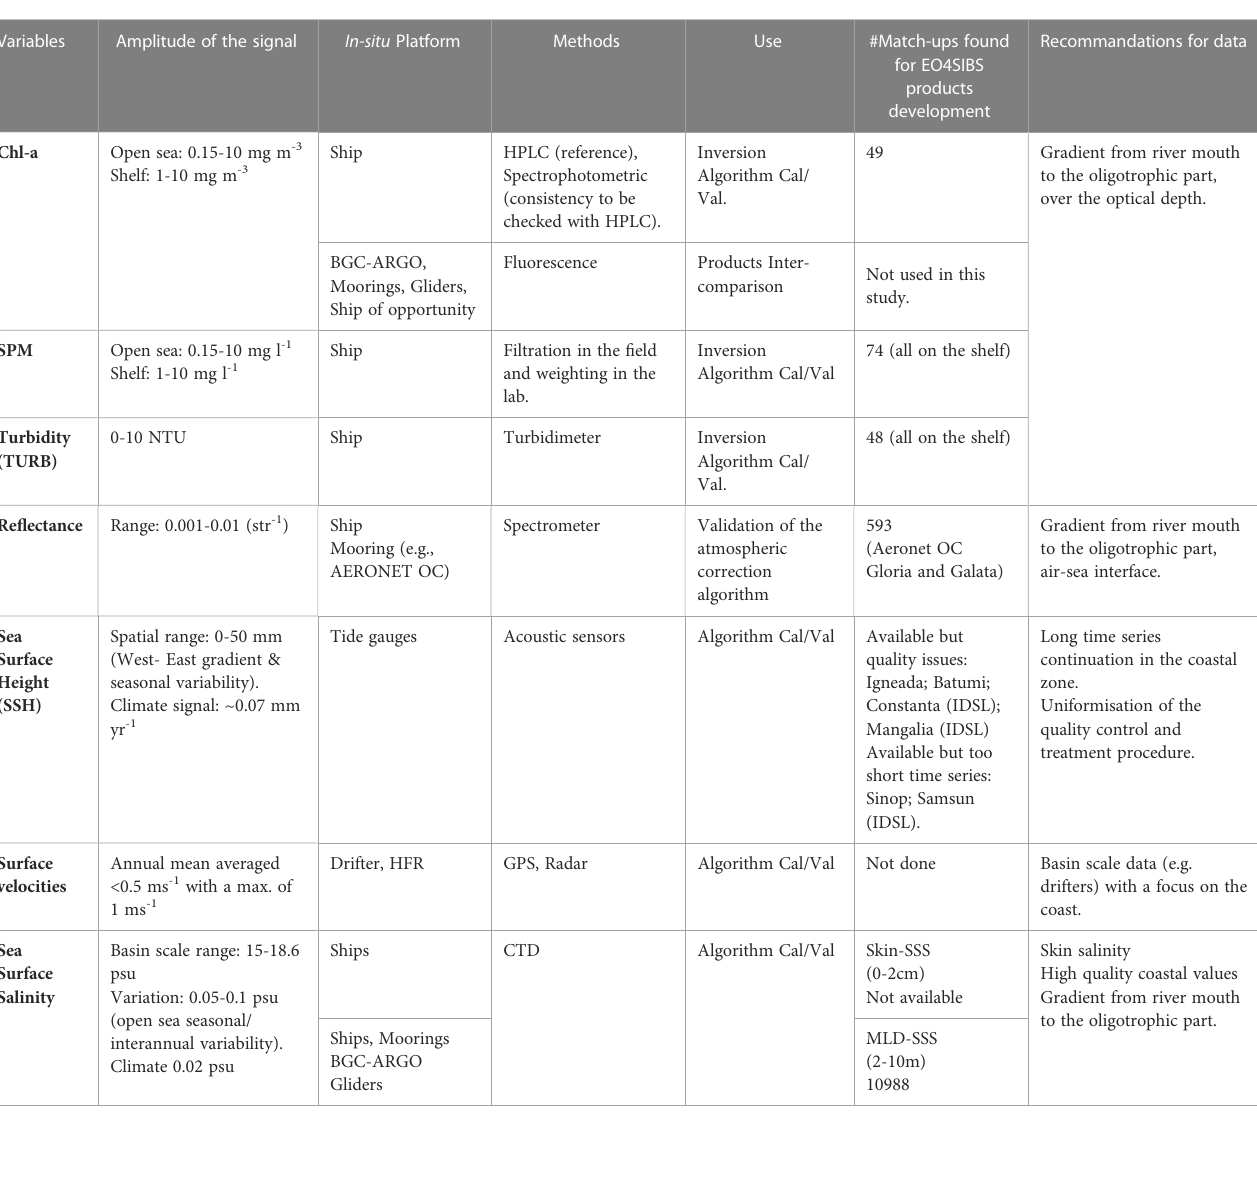
TABLE 2 Requirements for an observing system to support the development of EO products related to OC, SSS,